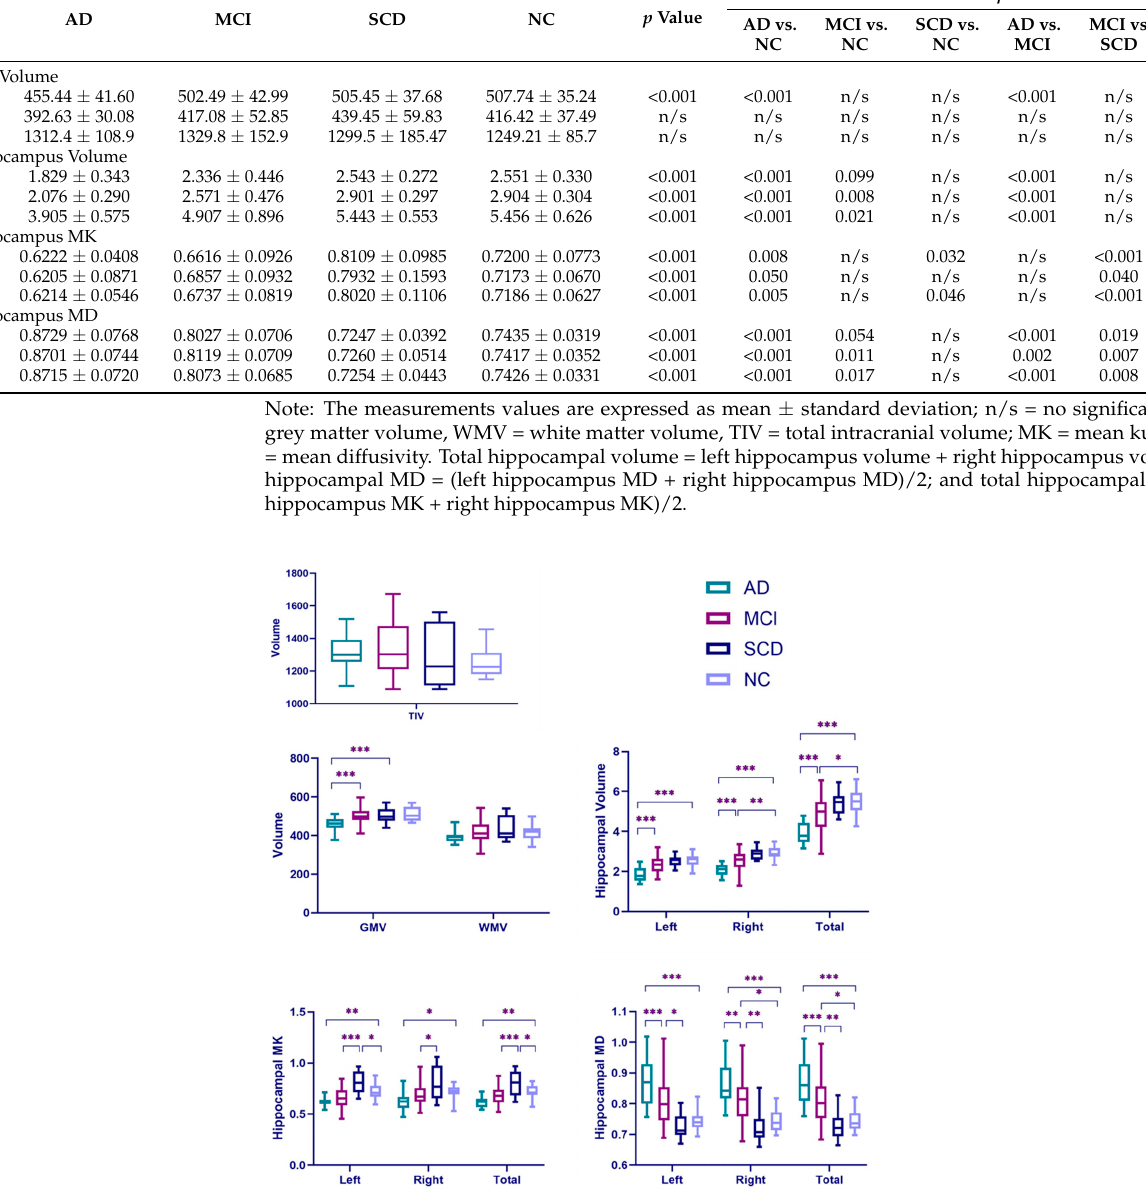
Table 4. AUC values for each pair-wise differential diagnosis.